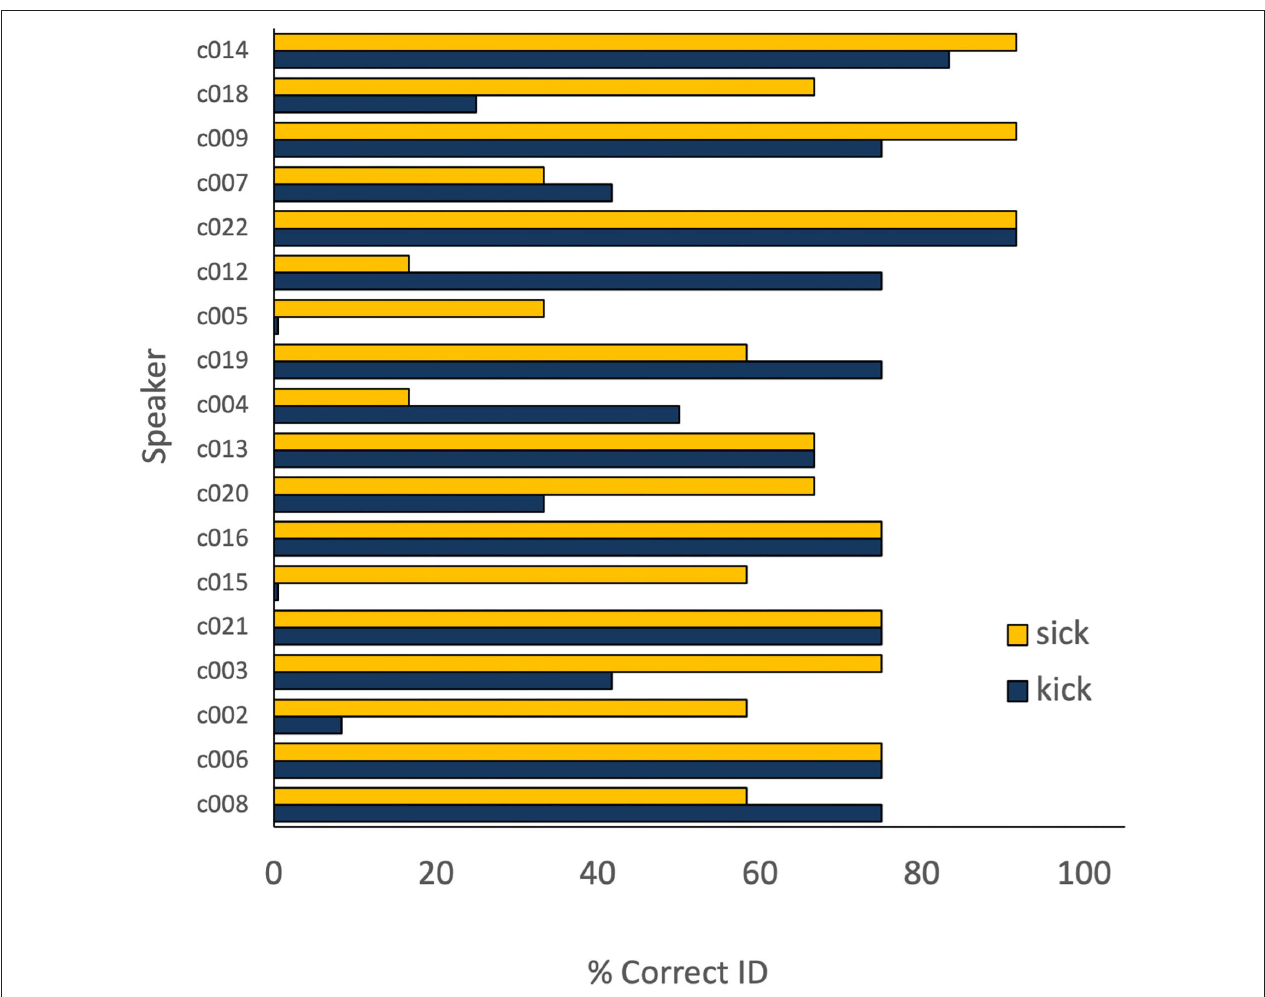
FIGURE 3 | Individual speaker performance (% intelligibility) on sick and kick